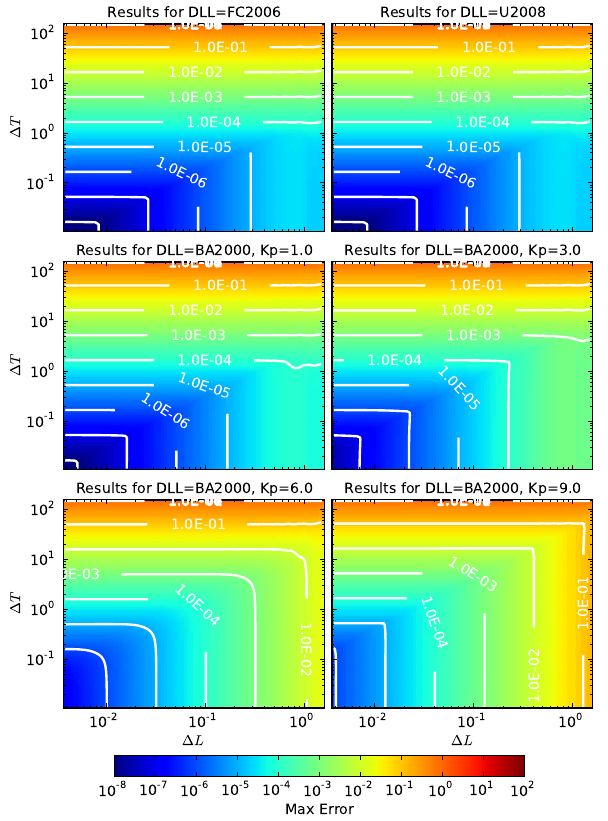
Fig. 7. Similar to Fig. 6, but for other D LL models.